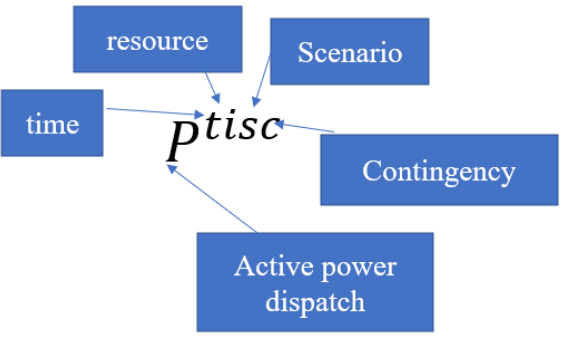
Figure 1. Nomenclature for active power dispatch in each scenario occurring in time period t .